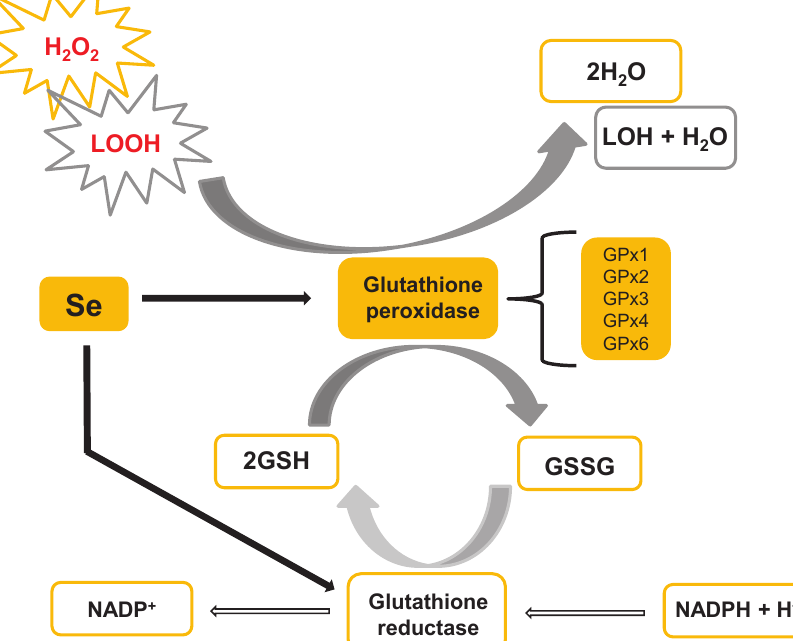
Figure 1 - Detoxification of hydrogen peroxide (H dependent glutathione peroxidase. Glutathione peroxidase activity requires two molecules of the tripeptide GSH, which is restored by the enzyme glutathione